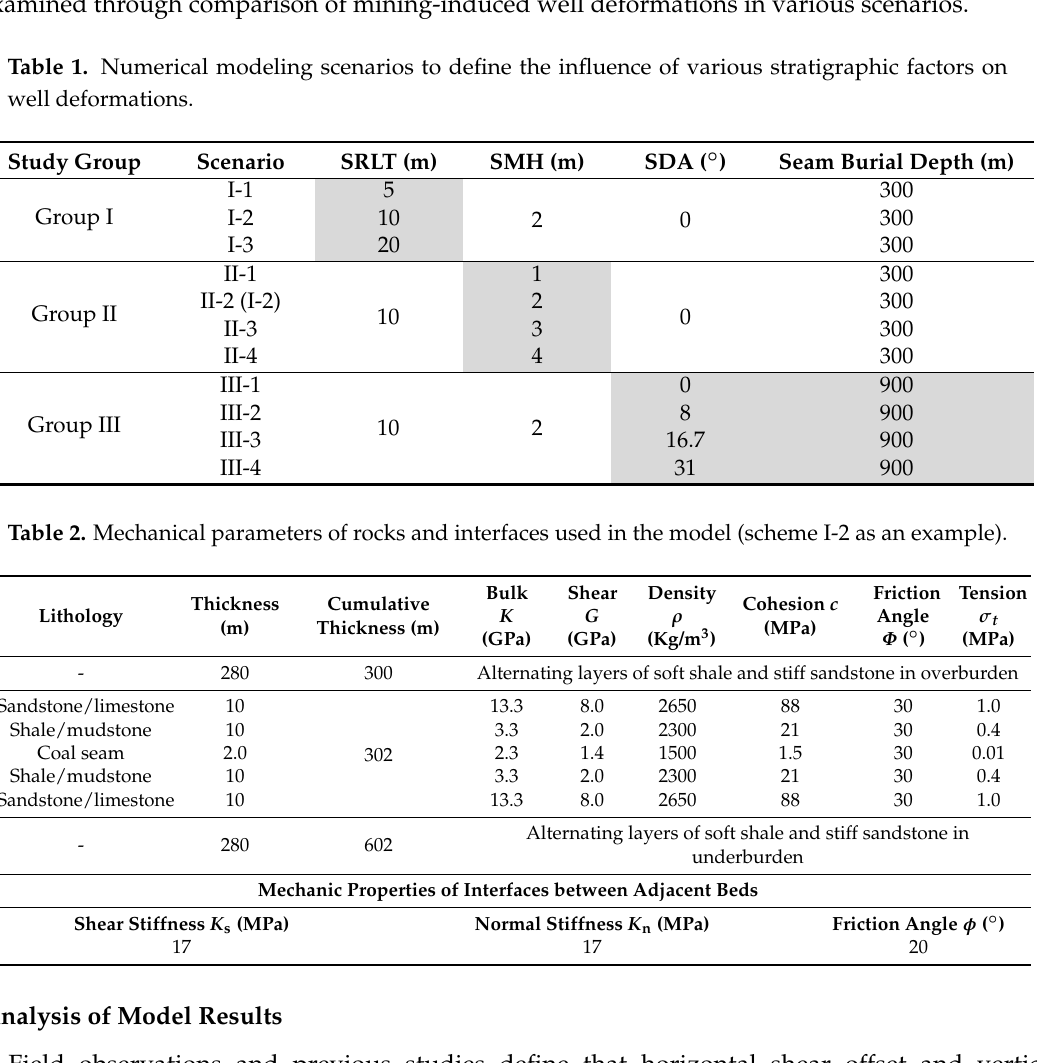
Table 2. The influence of SRLT, SMH and SDA on the deformation and stability of hydrocarbon wells